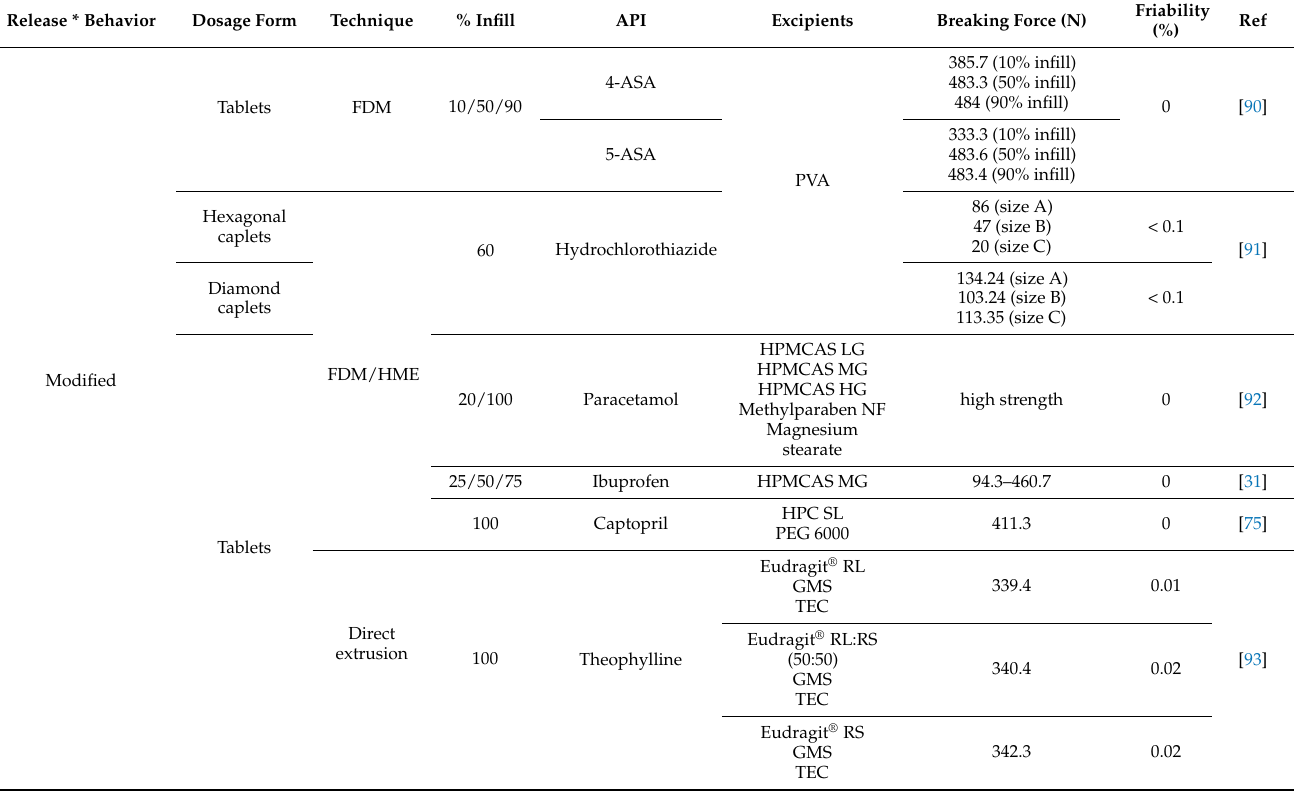
Table 5. Composition of 3D-printed solid oral dosage forms linked with technique % infill percentage, breaking force (N), friability (%), and grouped according to their modified release